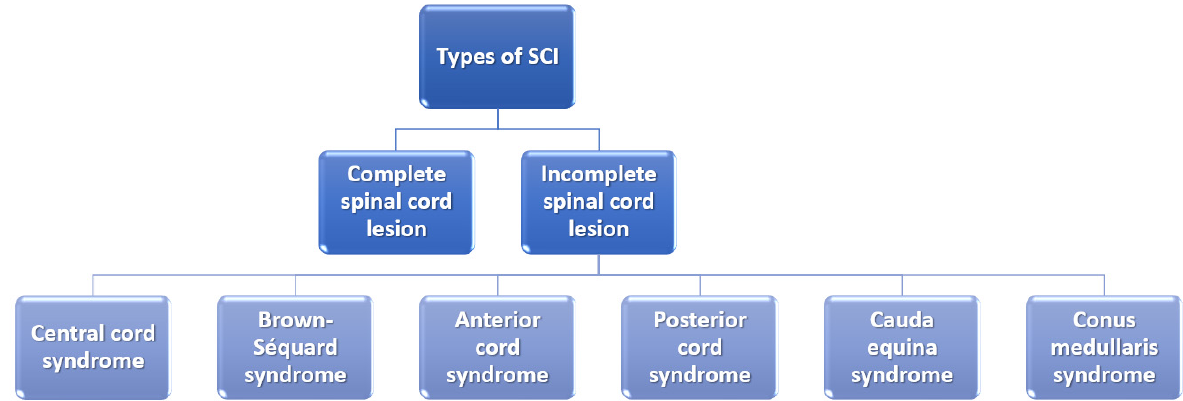
Figure 2. Classification of spinal cord injuries. Created based on information from [6,25].